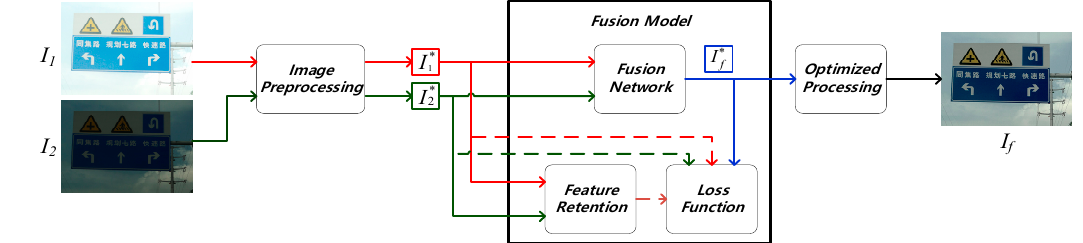
Figure 1. Multi-exposure image fusion framework.